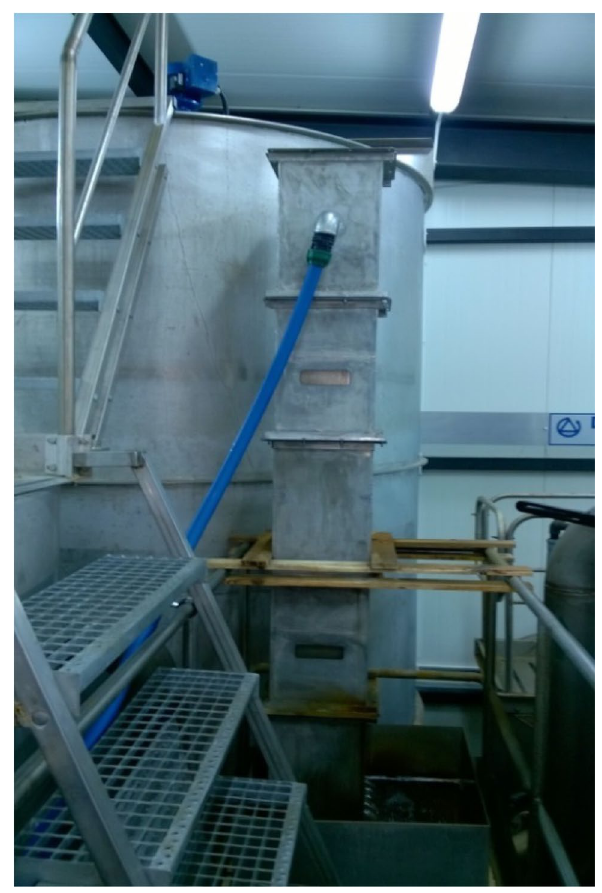
Fig. 2 Aerator for water aeration